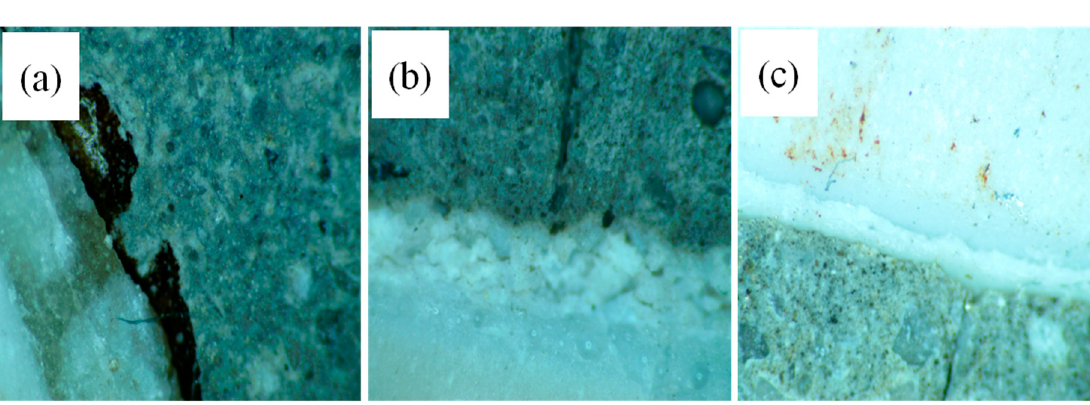
Figure 8. SEM images of porcelain of porcelain insulators; ( a ) 50 years, ( b ) 10 years. The insulators which had completed 50 years of service were highly porous as compared to the insulators which had completed 10 years of service. The lifetime of the porcelain insulator is highly dependent on the local environment of the installation site.The nature of pollutants, direction of wind, temperature, occurrence of rain or snow fall all affect the lifetime of porcelain insulators. These factors are responsible for the extent and rate of degradation of insulators. It is highly possible that two insulators possessing the same rating, age and manufacturing specifications, however different their installation site (rural and industrial), will reveal different lifetimes [34].